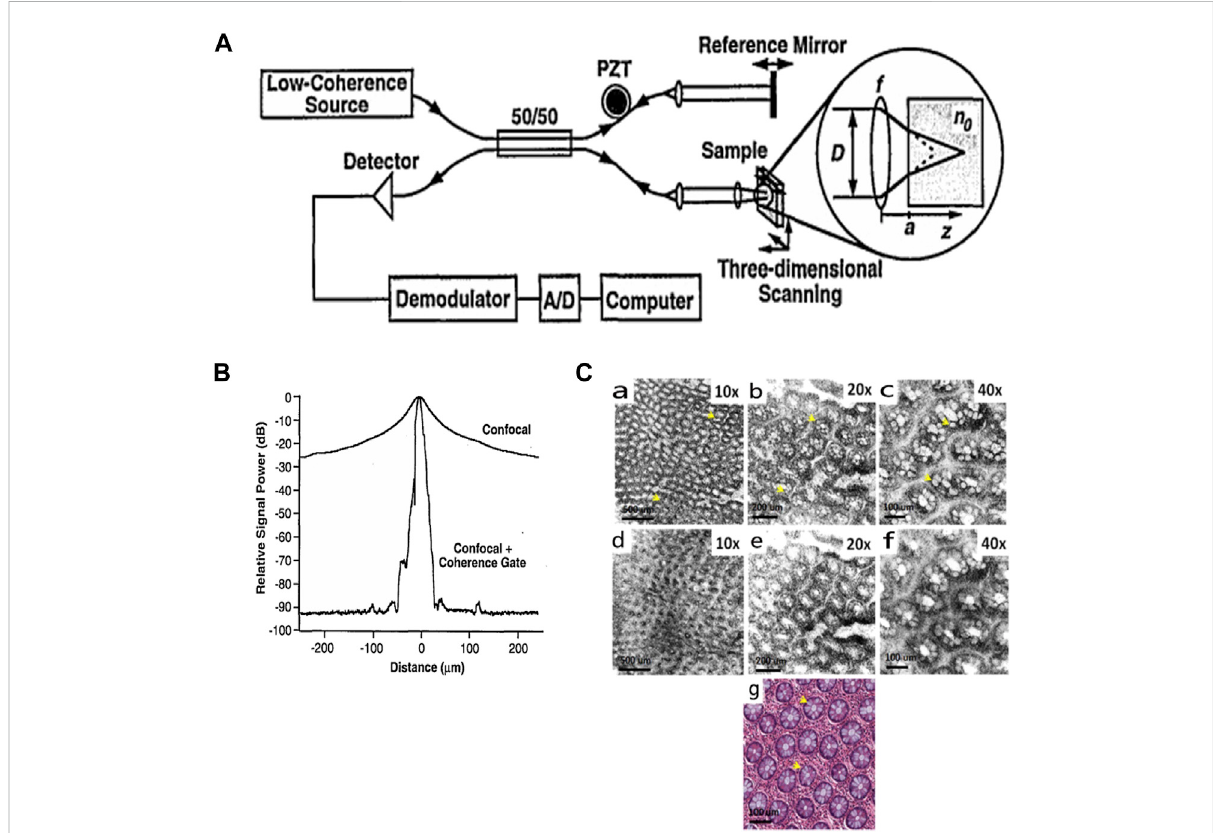
FIGURE 5 (A) Schematic of the optical coherence microscopy (OCM) system [70]. (B) Relative signal power of OCM and confocal microscopy as the displacementofthemirrorchanges.(NA=0.4,20xobjectivelens)[70] (C) (a – c) Exvivo OCMimagesandthecorresponding(d – f)simulatedconfocal images and (g) histology of fresh human colon specimen at different magni fi cations. Yellow arrows indicate goblet cells